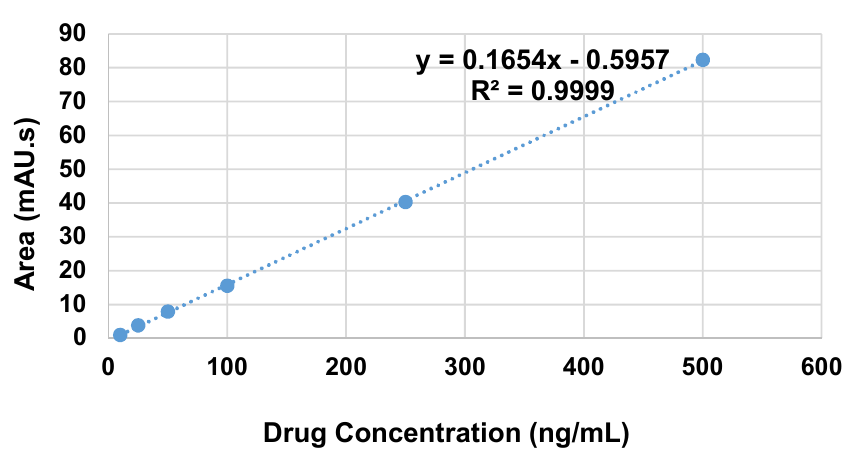
Figure 1. Cinnarizine calibration curve.